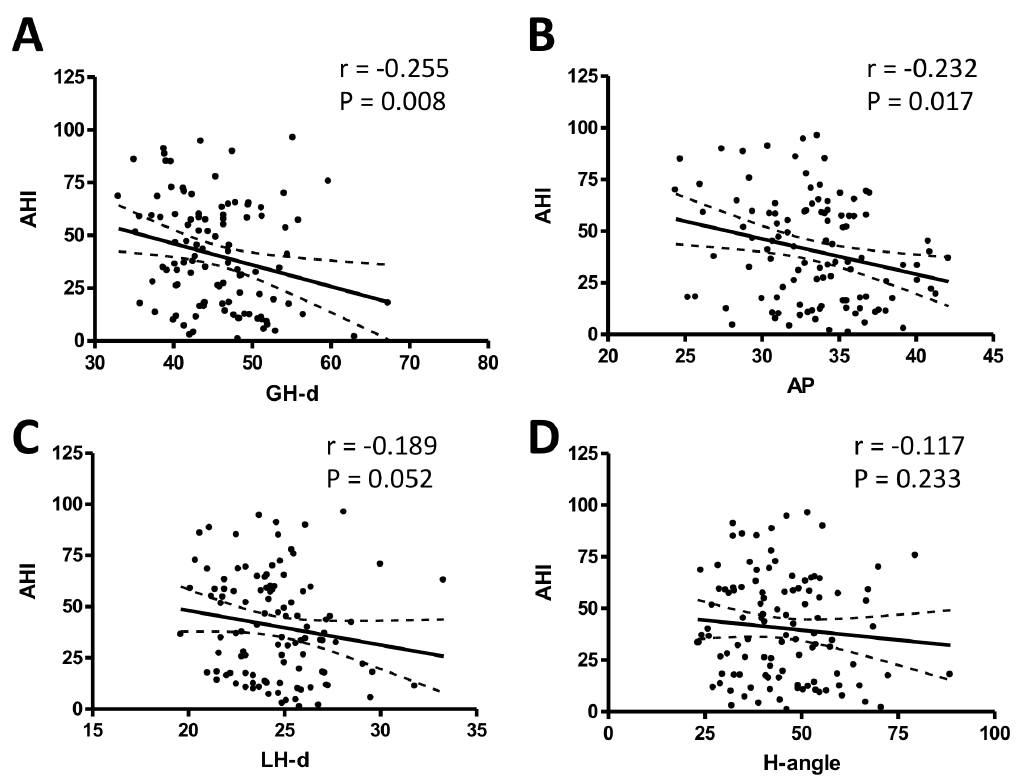
Figure 3. Correlation between apnea-hypopnea index (AHI) and parameters of the hyoid bone. A . GH-d is inversely correlated to the AHI (r= 2 0.255, P=0.008). B . AP is inversely correlated to the AHI (r= 2 0.232, P=0.017). C. LH-d has no correlation with the AHI (r= 2 0.189, P=0.052). D. H-angle has no correlation with the AHI (r= 2 0.117, P=0.233).